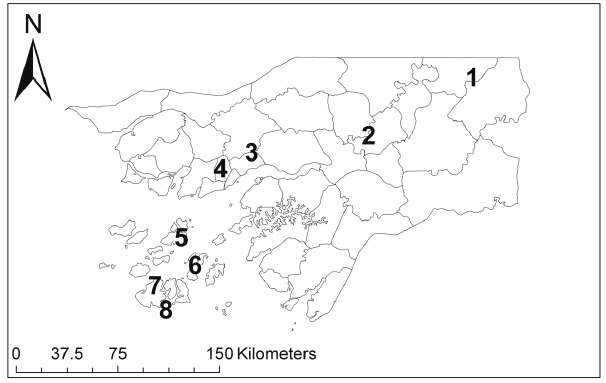
Figure 1. Collection sites in Guinea-Bissau. 1: Canjufa (12.43N, 14.13W), 2: Bambadinca (12.02N, 14.86W), 3: Antula